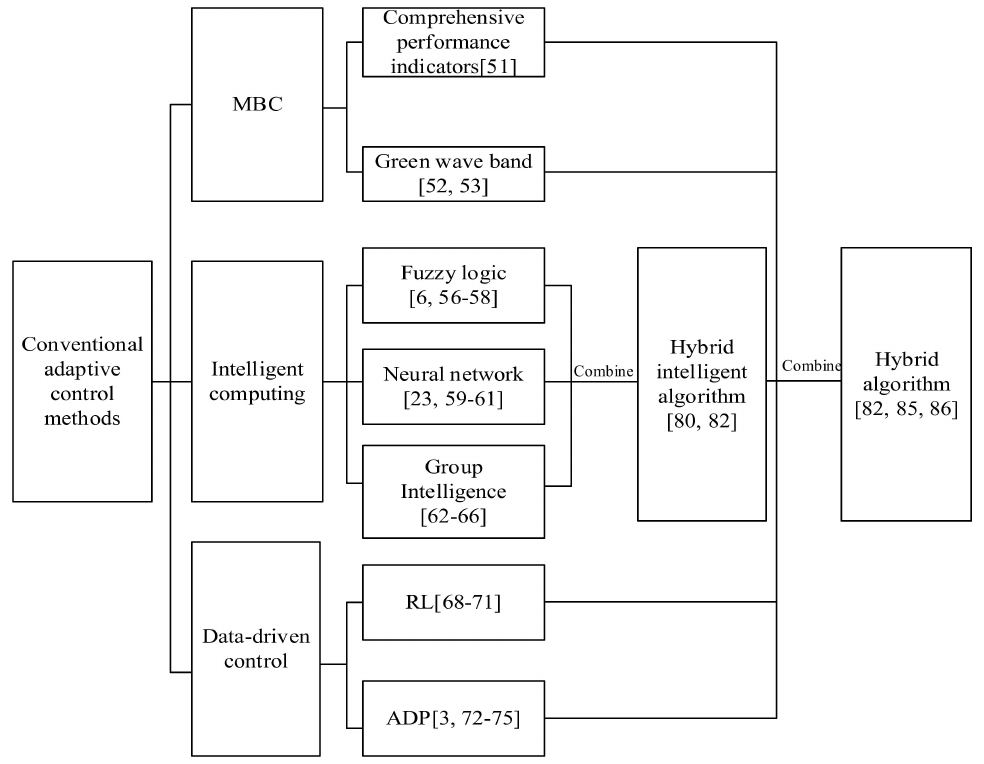
Figure 5. Overview of the conventional adaptive control